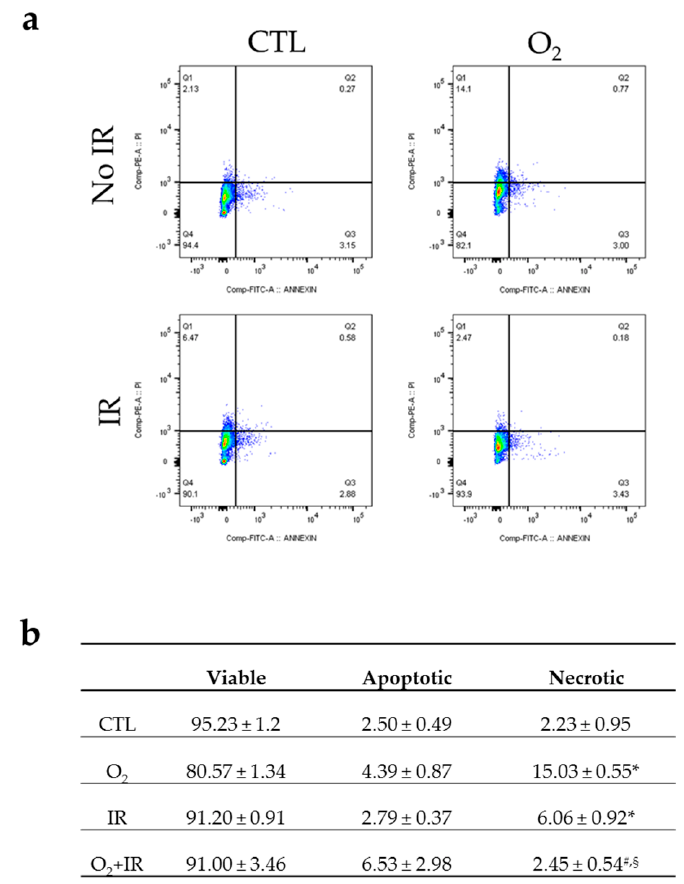
Figure 3. Flow cytometric analysis of apoptosis/necrosis stained with Annexin V-FITC and PI in lung epithelial cells 48 h (2 cycles) after exposure to hyperoxia, radiation, and double-hit combination challenge. Non-tumorigenic murine alveolar type II epithelial cells (C10) were evaluated after 2 cycles of hyperoxia and radiation exposure and evaluated by flow cytometric analysis of apoptosis/necrosis stained with Annexin V-FITC and PI. ( a ) Representative flow cytograms depicting Annexin V-FITC